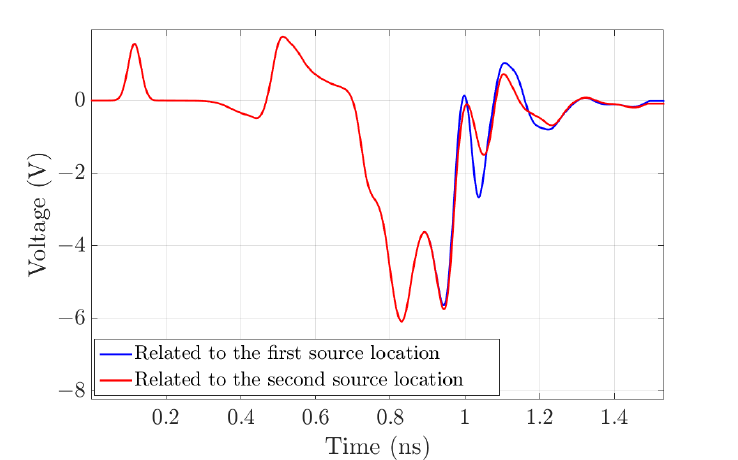
Figure 24. Thereflected voltage of the simple blade has two invisible zigzag cracks at two different source